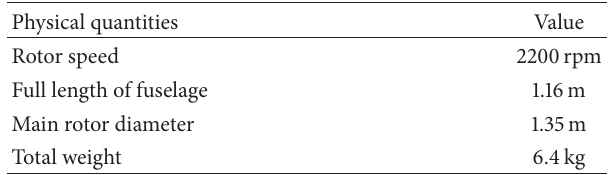
Table 1: General physical parameters of TREX 600